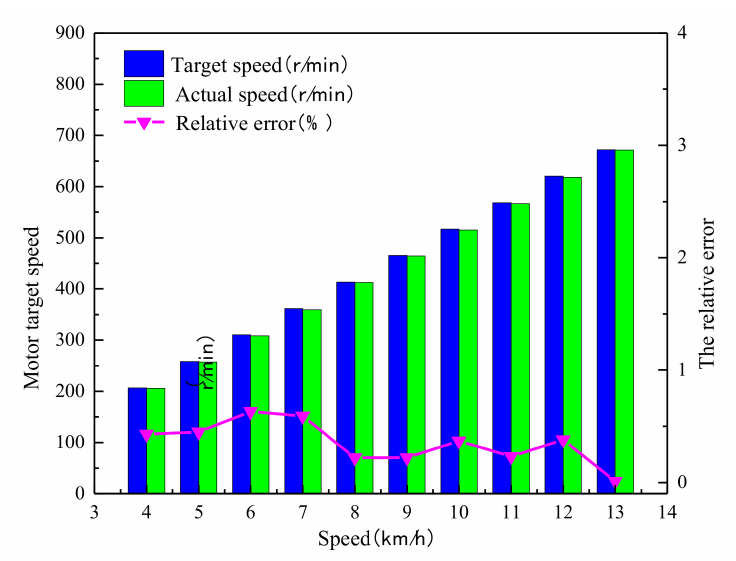
Figure 11. Speed accuracy detection.